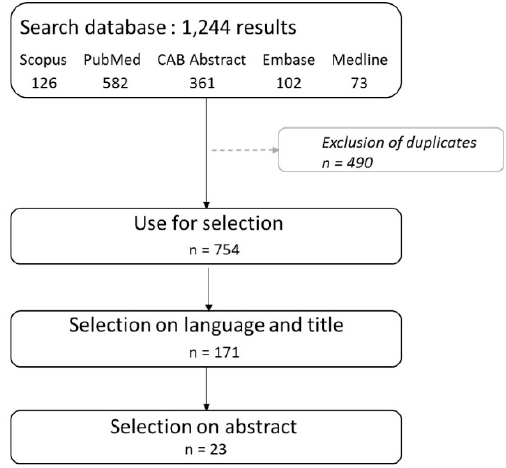
Figure 6. Selection process of articles and the result of the literature review.